Question: Write a caption explaining this figure to a reader.
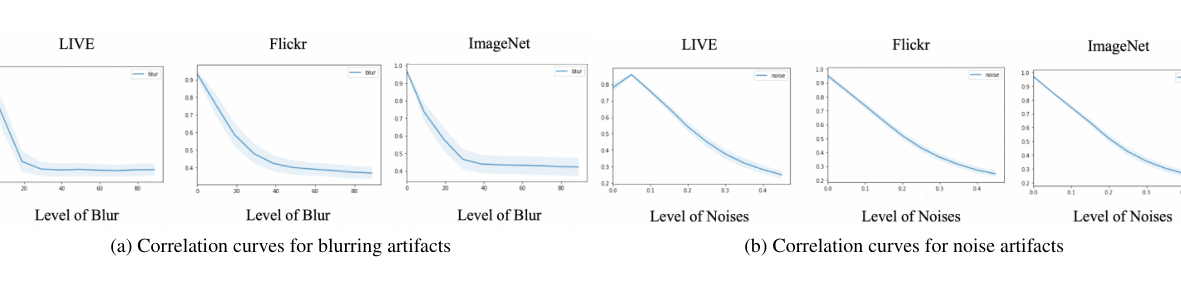
Answer: Correlation curves between the severity of the corruption artifacts and the QF prediction from the pre-trained network.